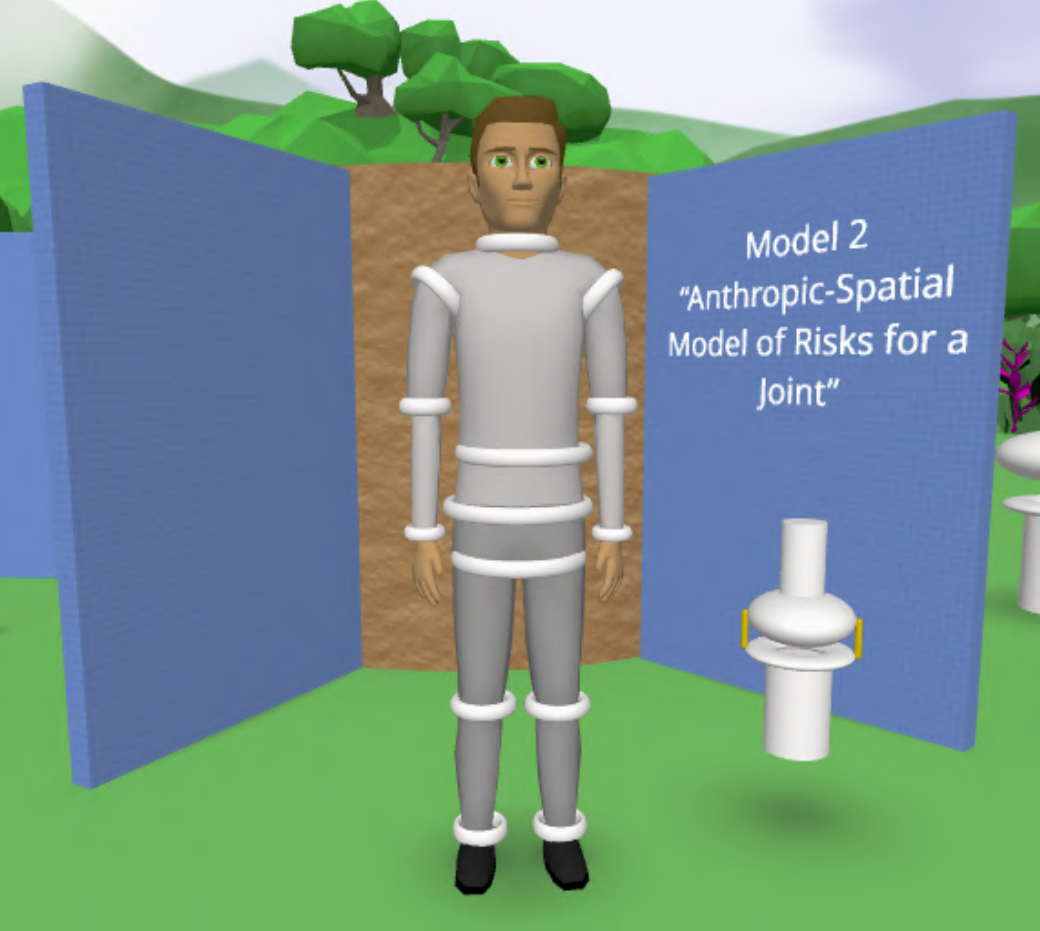
Figure 10: “Virtual Model of Identifying the Risks for Locomotor Apparatus Caused by Ligament Stretching”: Model 2 – “Anthropic-Spatial Model of Risks for a Joint”